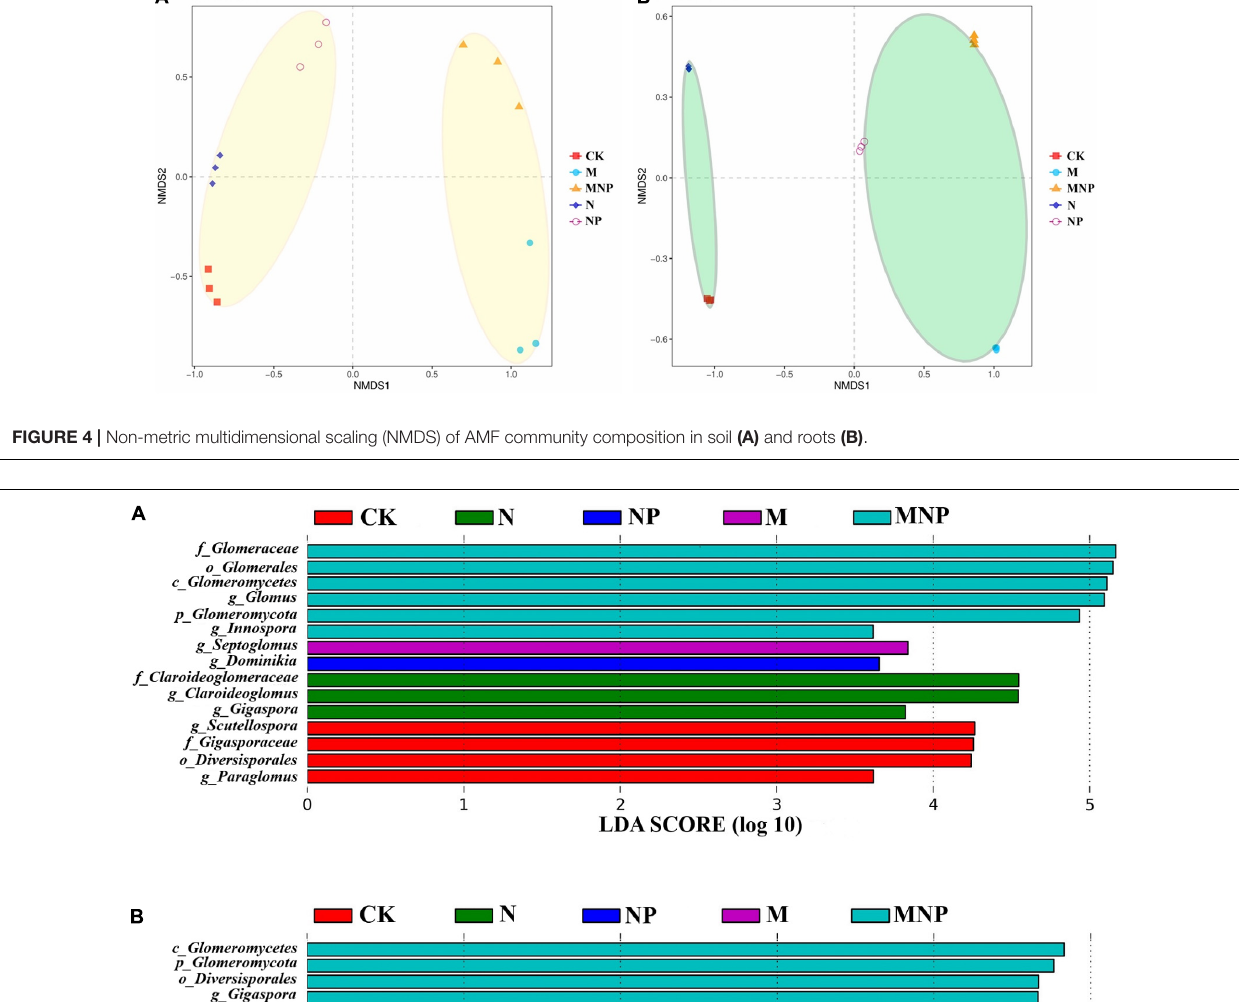
release from pig manure may be slower than that of chemical fertilizer at this time (Wang et al.,